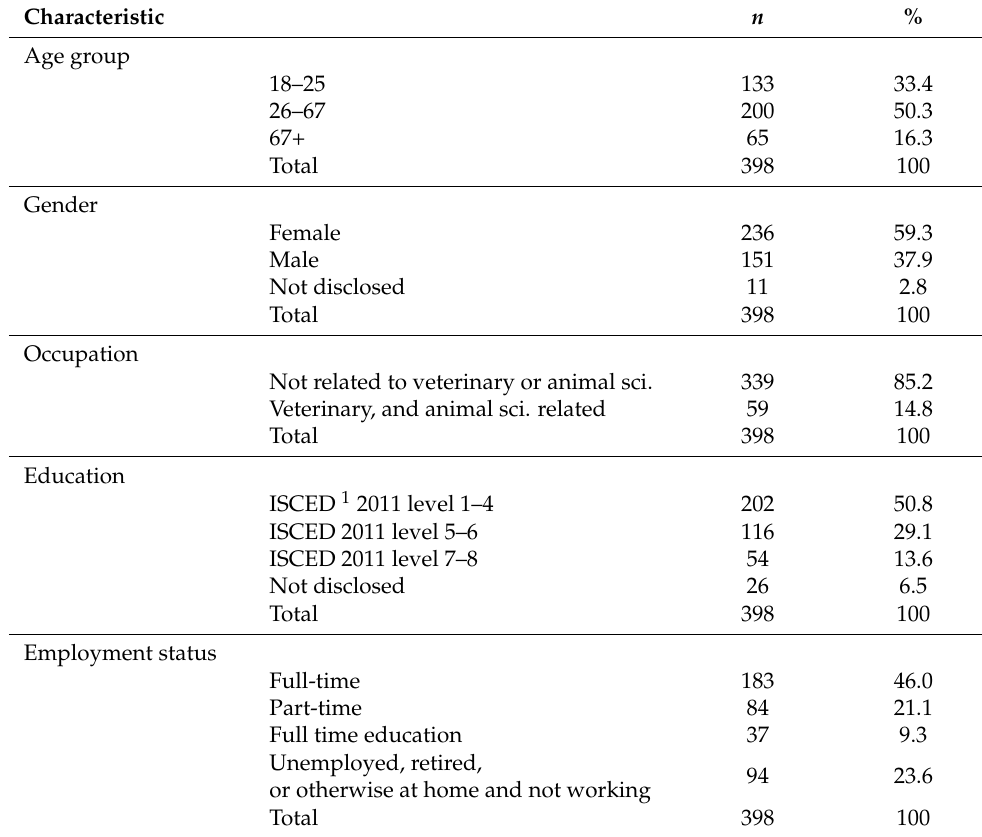
Table 2. Respondents’ demographics.